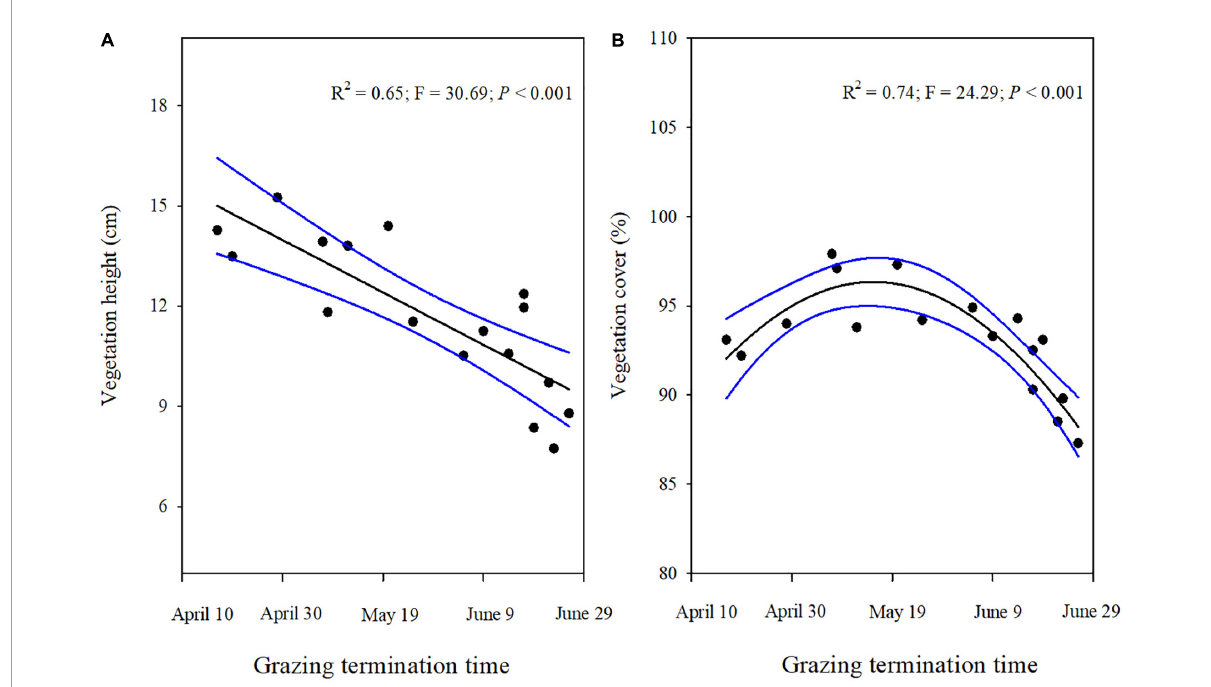
FIGURE2 Vegetation height (A) and Vegetation cover (B) for different grazing termination times on winter pastures in alpine meadows based on linear regressions. The black lines indicate significant regression relationships and blue lines indicate the smoothed regressions with its 95% confidence intervals.